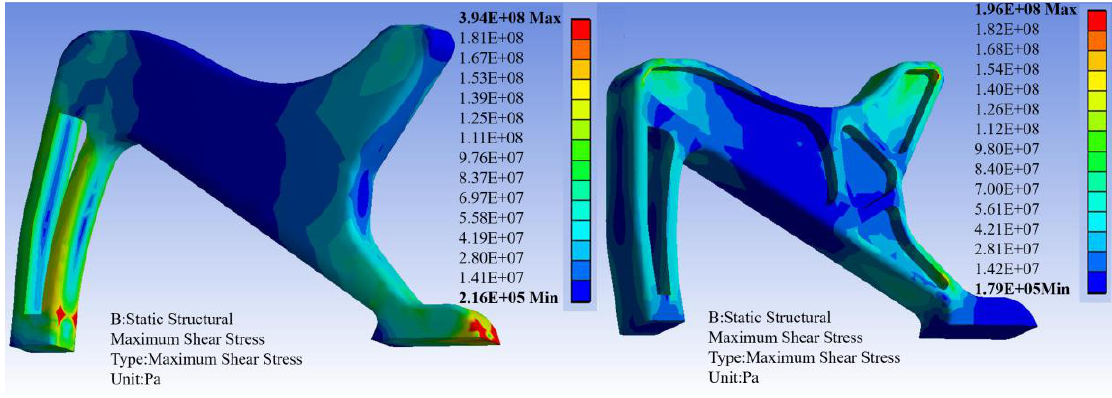
Figure 19. Stress analysis for comparison of the supporting planar plate (maximum shear stress).